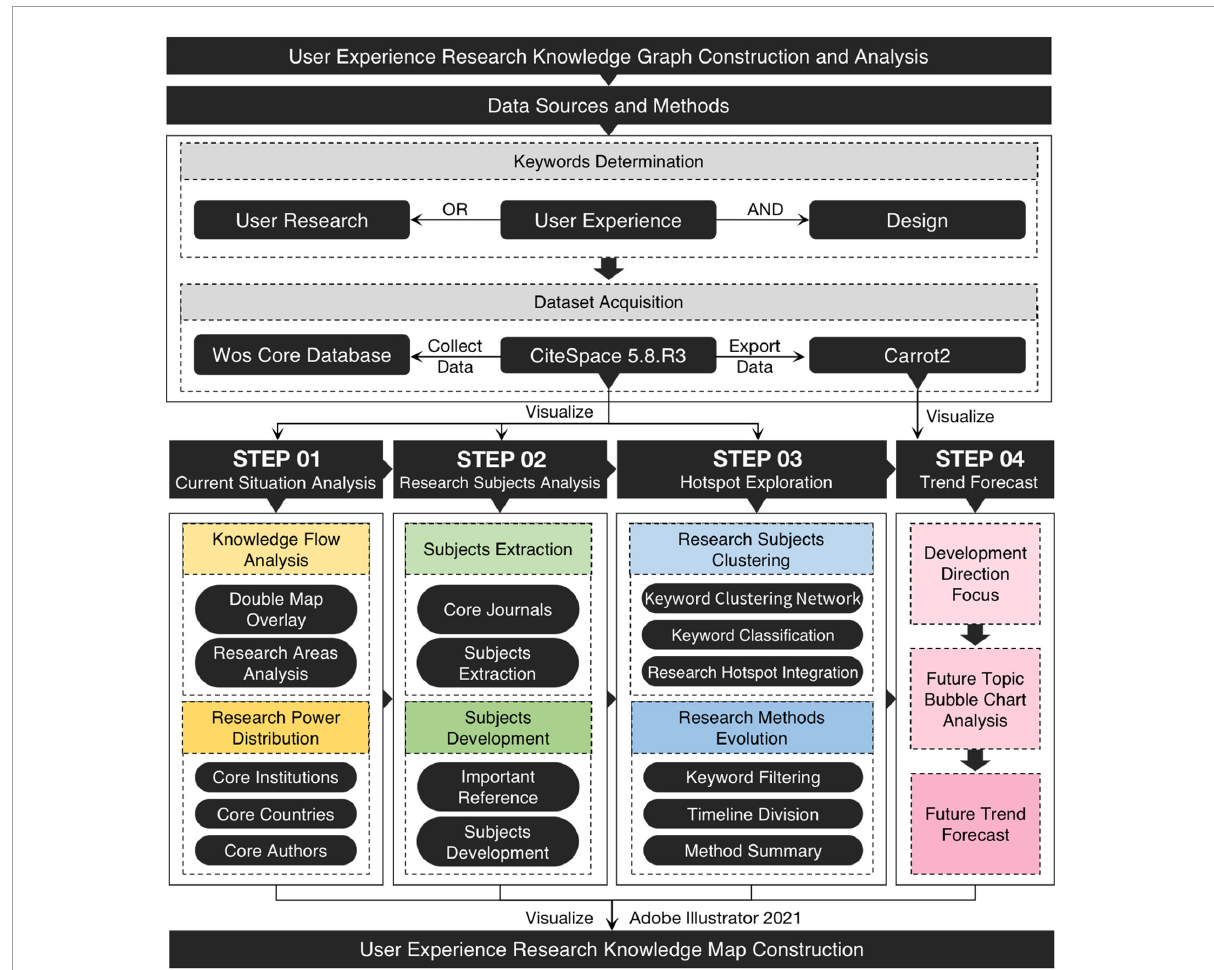
FIGURE1 The research framework of this